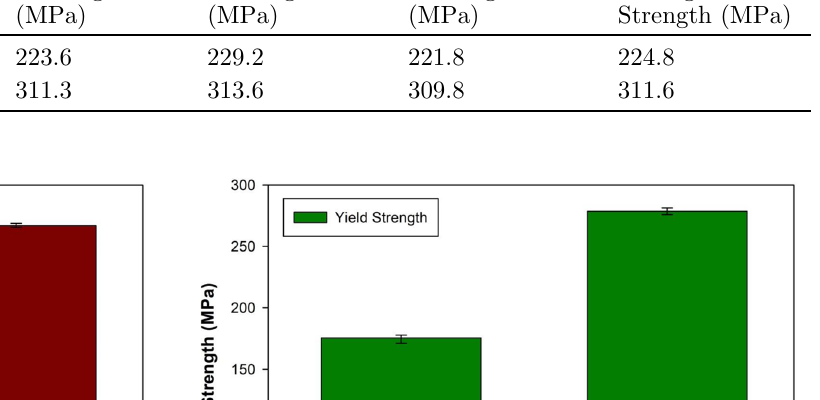
Table 3. Ultimate tensile strength of Al2214 alloy and B Sl No.